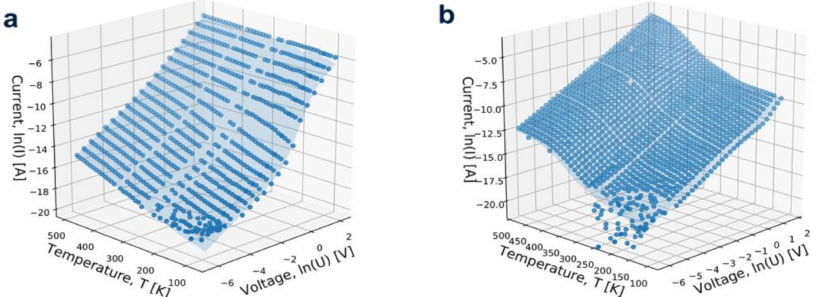
Figure 9. The I-V-T characteristics of the heterojunctions ( a ) DFI and ( b ) DFII collected in the forward configuration plot as a function of the voltage and the temperature indicate that the heterojunctions ( a ) DFI and ( b ) DFII have a supposedly calculated conducting face.